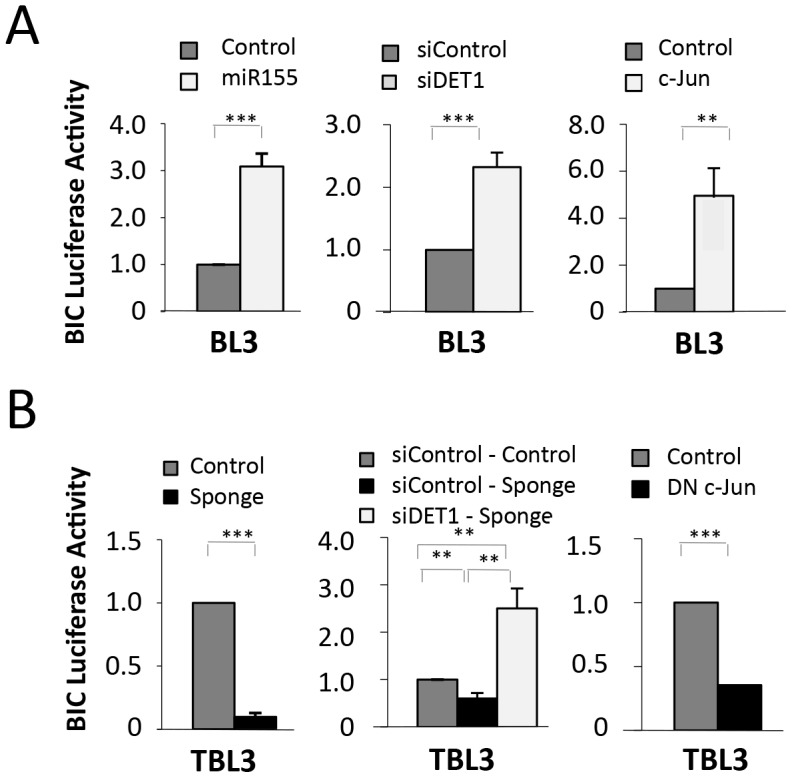
miR-155 drives a feedback regulatory loop.
(A) miR-155 directly regulates the BIC promoter. In unparasitized BL3 cells, transfection with miR-155, siDET1 or c-Jun led to induction of the BIC-Luciferase reporter. Relative luciferase results are shown compared to control transfections in BL3 cells (dark grey bars) (average ± sd, n = 3). (B) In contrast, in TBL3 cells, inhibiting miR-155 or c-Jun (with plasmids encoding miR-155 Sponge or Dominant Negative DN-c-Jun, respectively) led to reduced BIC-Luciferase reporter activity (average ± sd, n = 3). *p<0.05, **p<0.01, ***p<0.001.